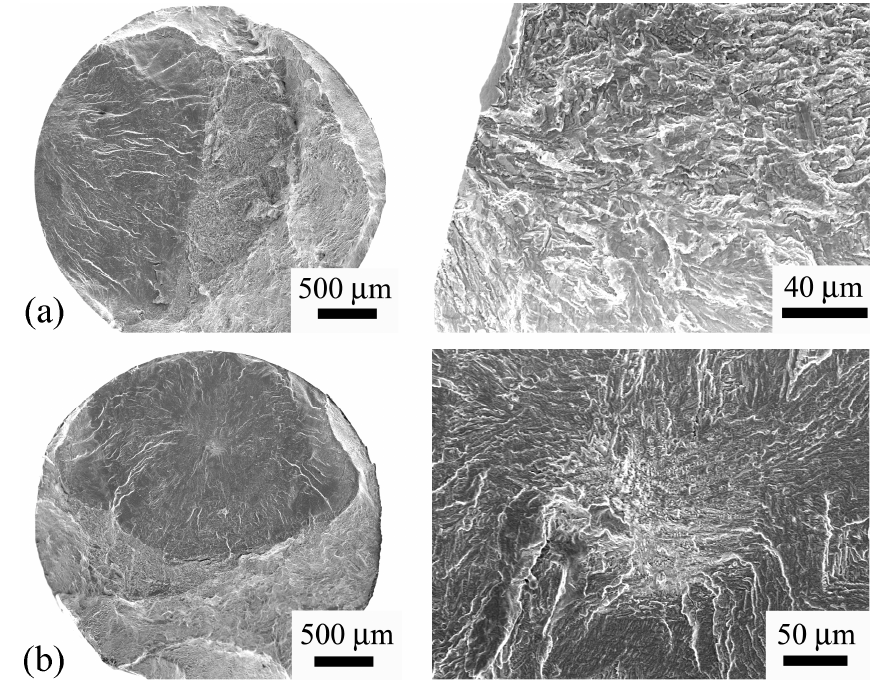
Figure 7. SEM observations of fracture surfaces for HU specimens. ( a ) Crack initiates from specimen surface, σ a = 635 MPa, N f = 2.91 × 10 7 ; ( b ) Crack initiates from the interior of specimen, σ a = 600 MPa, N f = 4.65 × 10 8 .